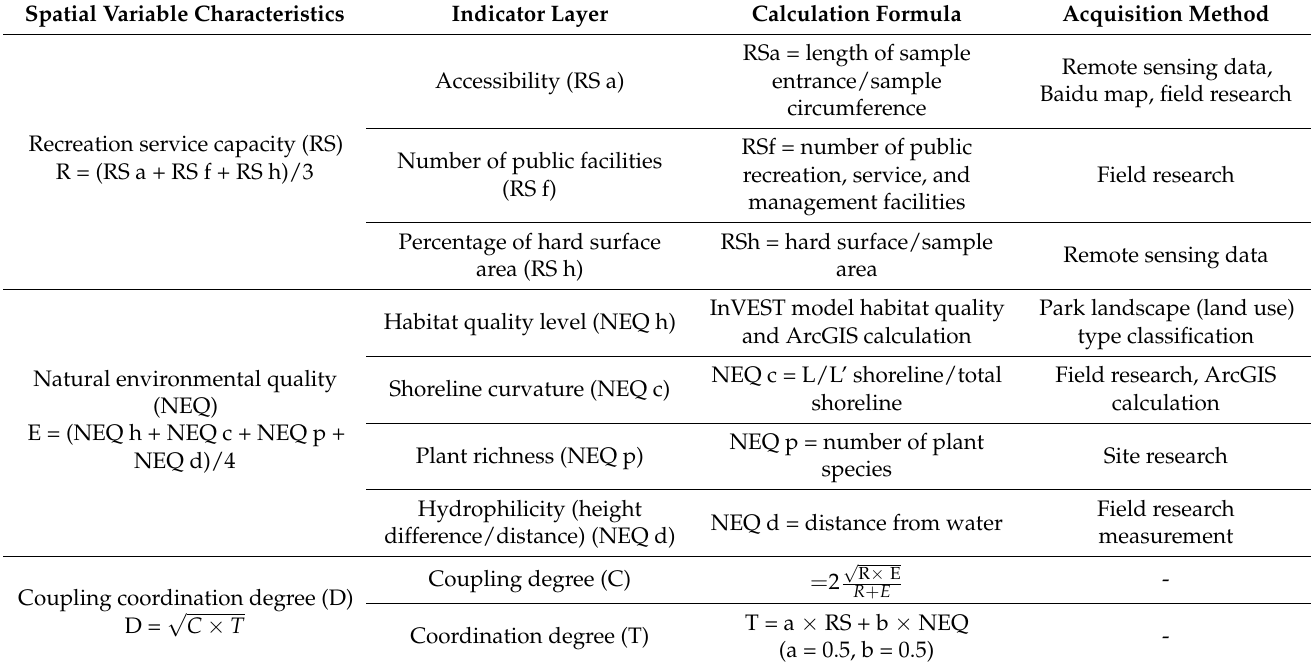
Table 1. Calculation and data acquisition methods for the spatial characteristic variables of green space.